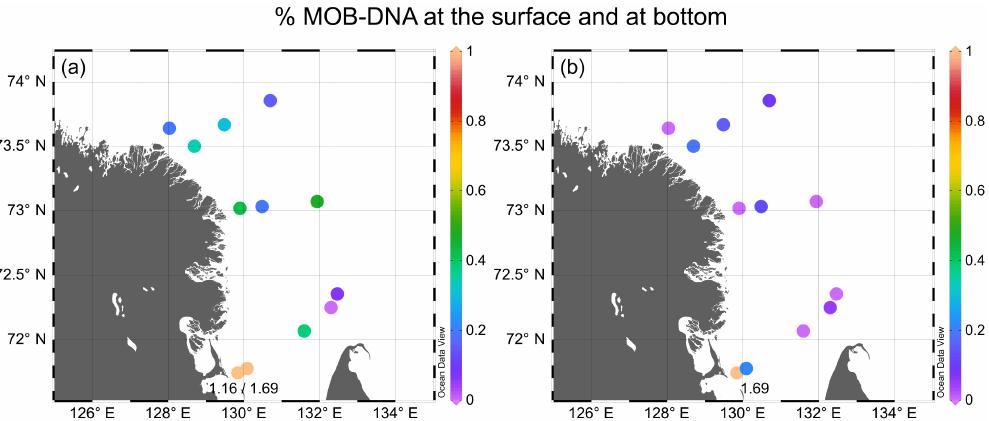
Figure 6. Relative abundance of methanotrophic DNA (as %MOB-DNA) in surface (a) and bottom (b) water around the Lena Delta. For stations with very high methane concentrations, the values are annotated in the figure. Table 4. The occurrence and association of the MISA OTUs to different water masses, their assignation to known methanotrophic groups and the results of a Kruskal–Wallis test for significant differences in occurrence ( ∗ , p < 0 . 05). MISA OTU Assignation Riverine